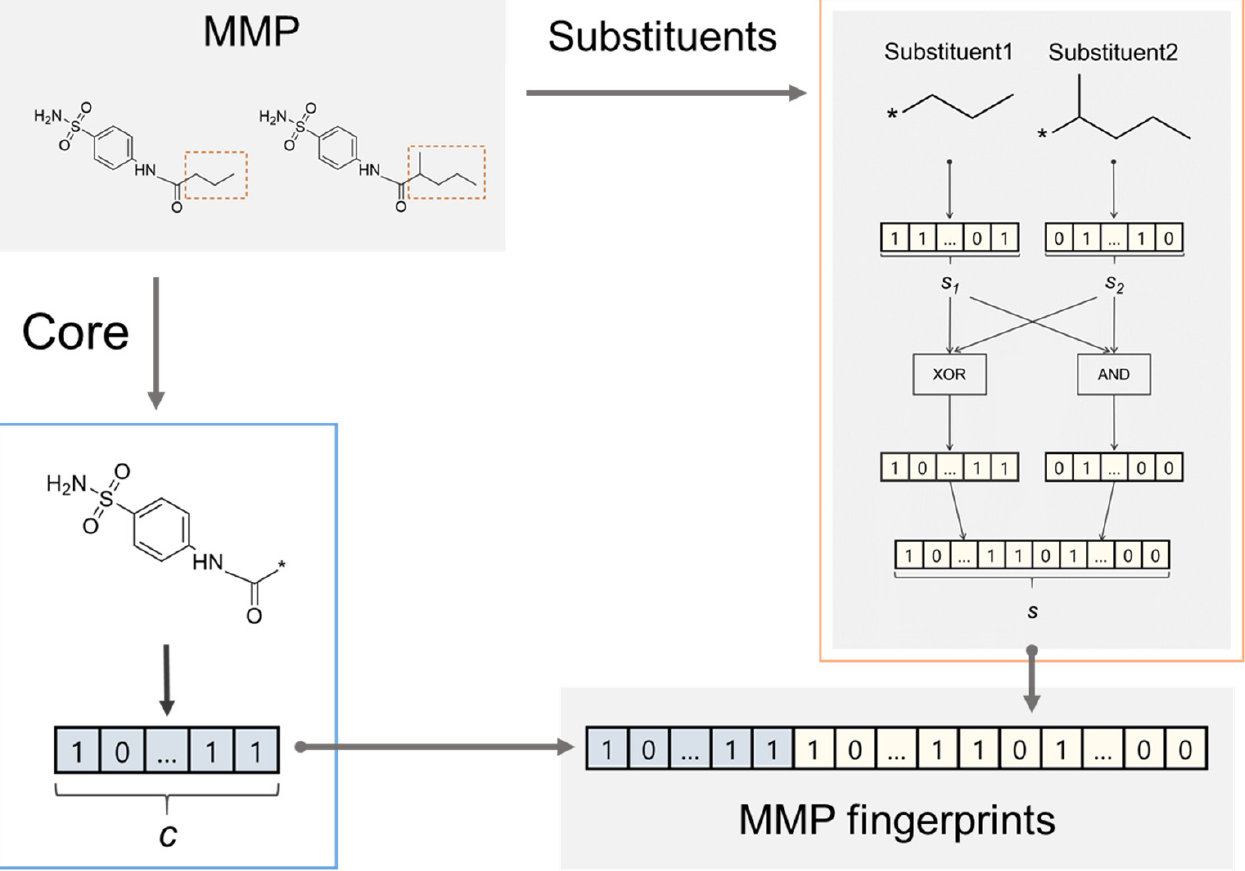
Figure 4. Fingerprint generation for MMPs. An MMP is formed by two compounds that share a common scaffold (core) and individual substituents. From each MMP, one core and a set of two substituents were extracted, and then fingerprints were generated for each part. Two types of fingerprints were concatenated to obtain fingerprints representing substituents. One is calculated by taking the XOR operation of two fingerprints of given substituents and the other is calculated by taking the AND operation to represent specific and common features. Finally, MMP fingerprints were generated by concatenating fingerprints for the core and